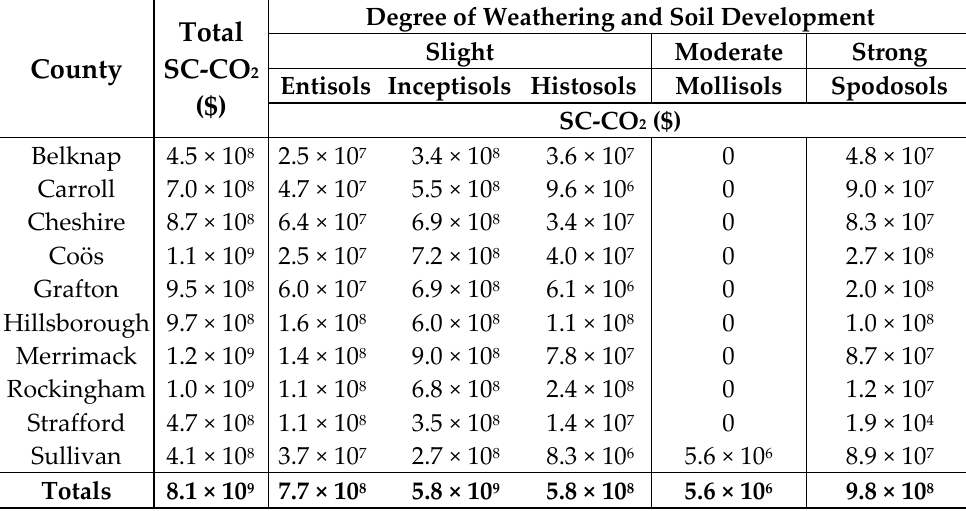
Table 8. Monetary value of soil inorganic carbon (SIC) by soil order and county for the state of New Hampshire (USA), based on the areas shown in Table 3 and the area-normalized midpoint monetary values shown in Table 4.